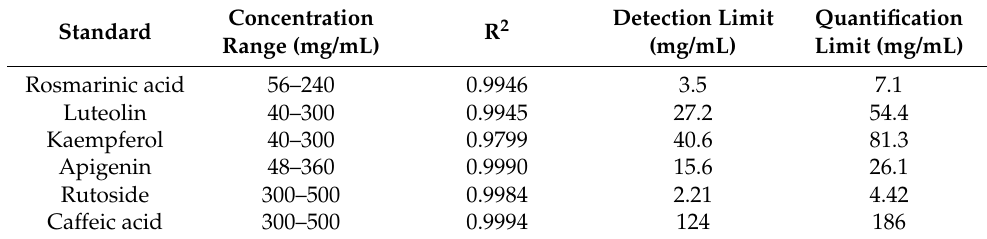
Table 3. The data obtained for the reference calibration